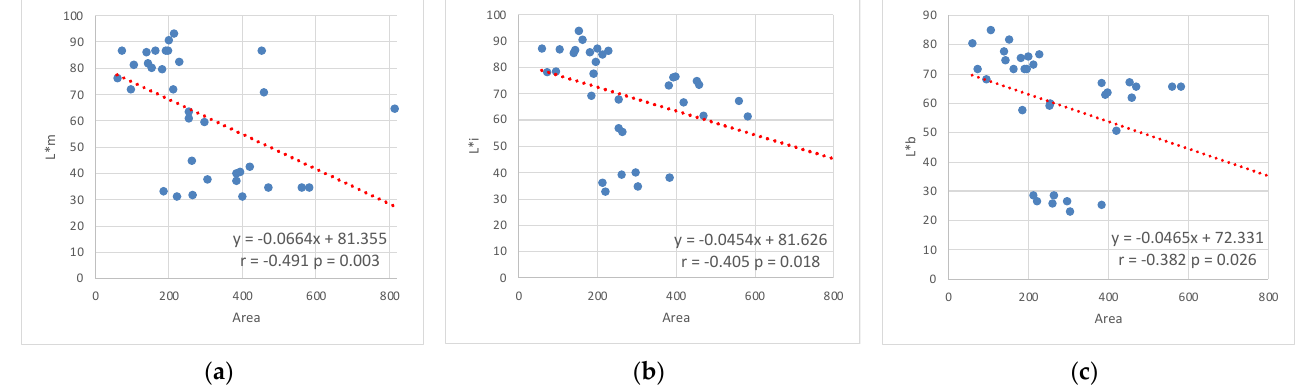
Figure 19. Correlation between the area of the triangle in CIELAB color space and the lightness (L) ( a ) of the main (m), ( b ) “intermediary” (i), and ( c ) background ( b ) colors.